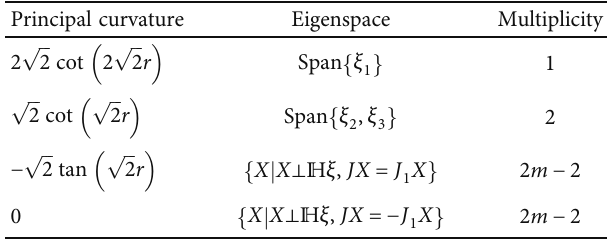
Table 1: Principal curvatures and corresponding